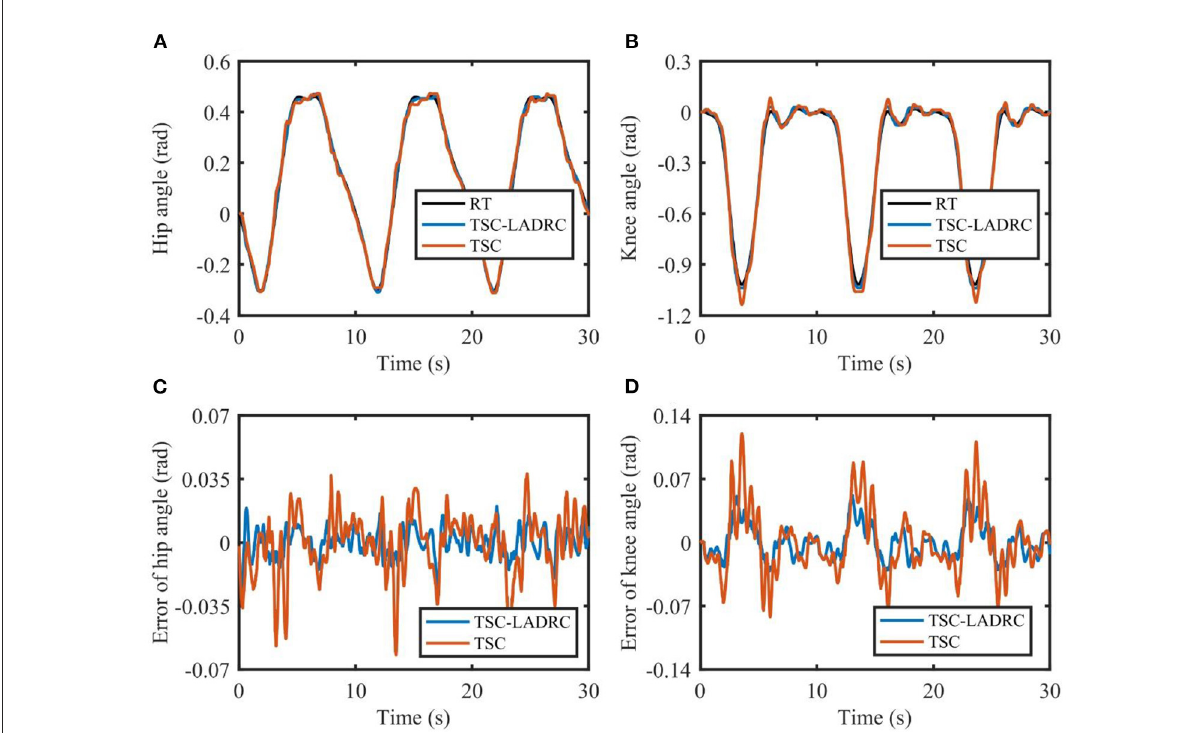
FIGURE6 Tracking performance of the exoskeleton robot under TSC-LADRC and TSC. (A,B) are the joint angles of the hip and knee. (C,D) are the tracking errors of the hip and knee. RT, reference trajectory.